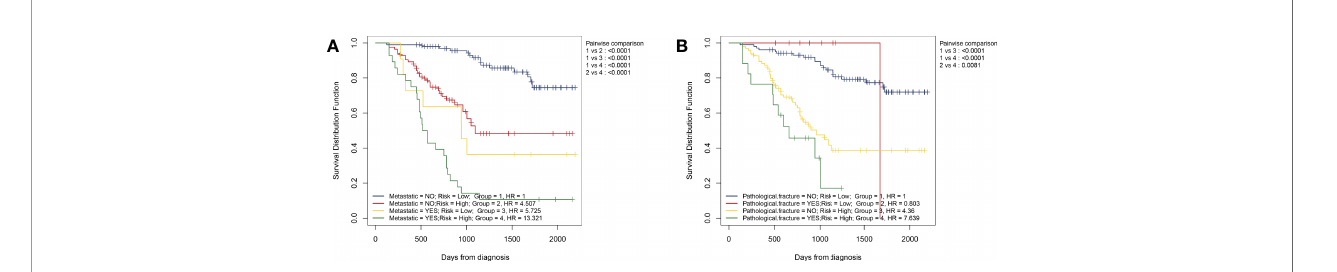
FIGURE 6 | Simple combination of HPSS and clinical features can better predict the prognosis of patients with osteosarcoma. (A) Patients with osteosarcoma can be divided into four groups according to tumor metastasis status and HPSS risk, and the KM survival curve shows the difference in survival among the four groups; (B) Patients with osteosarcoma can be divided into four groups according to pathological fracture status and HPSS risk, and the KM survival curve shows the difference in survival among the four groups.